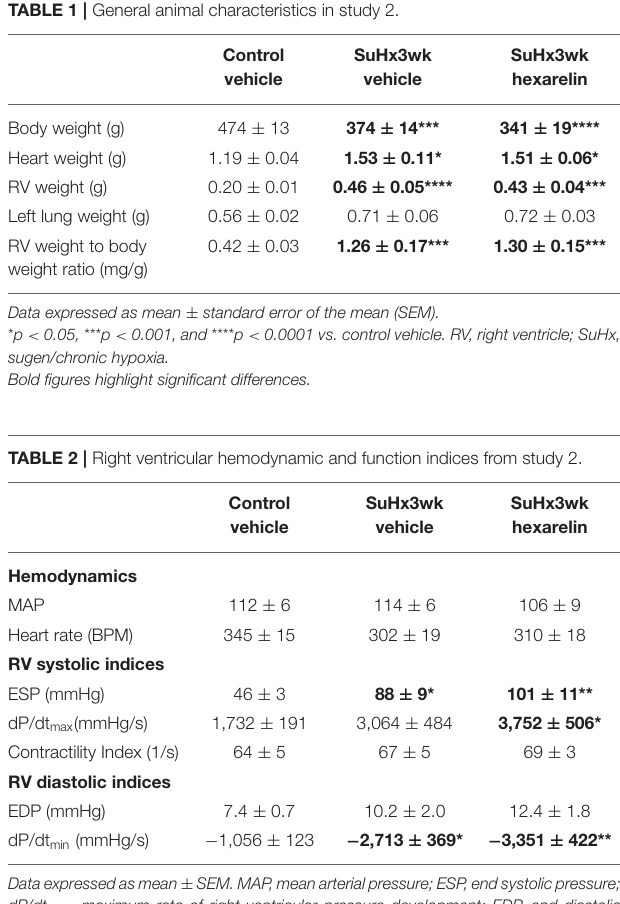
FIGURE 3 | administration (100 µ g · kg − 1 ). (D) ACh infusion (3 µ g · kg − 1 · min − 1 ). (E) Group mean visualized vessel number and vessel caliber and their relative changes from baseline (JMV blockade) or relative to blockade (hex, ACh). Yellow asterisks indicate dilation or new visual segments. Red asterisks indicate constricted segments. Tungsten wire (50 µ m) in the images was used for calibration. A two-way ANOVA was performed to compare factors of treatment group, vessel branching order, or size class followed by Bonferroni’s post hoc test to establish within group differences. * p < 0.05, ** p < 0.01, *** p < 0.001 difference from zero change, one sample t -test.